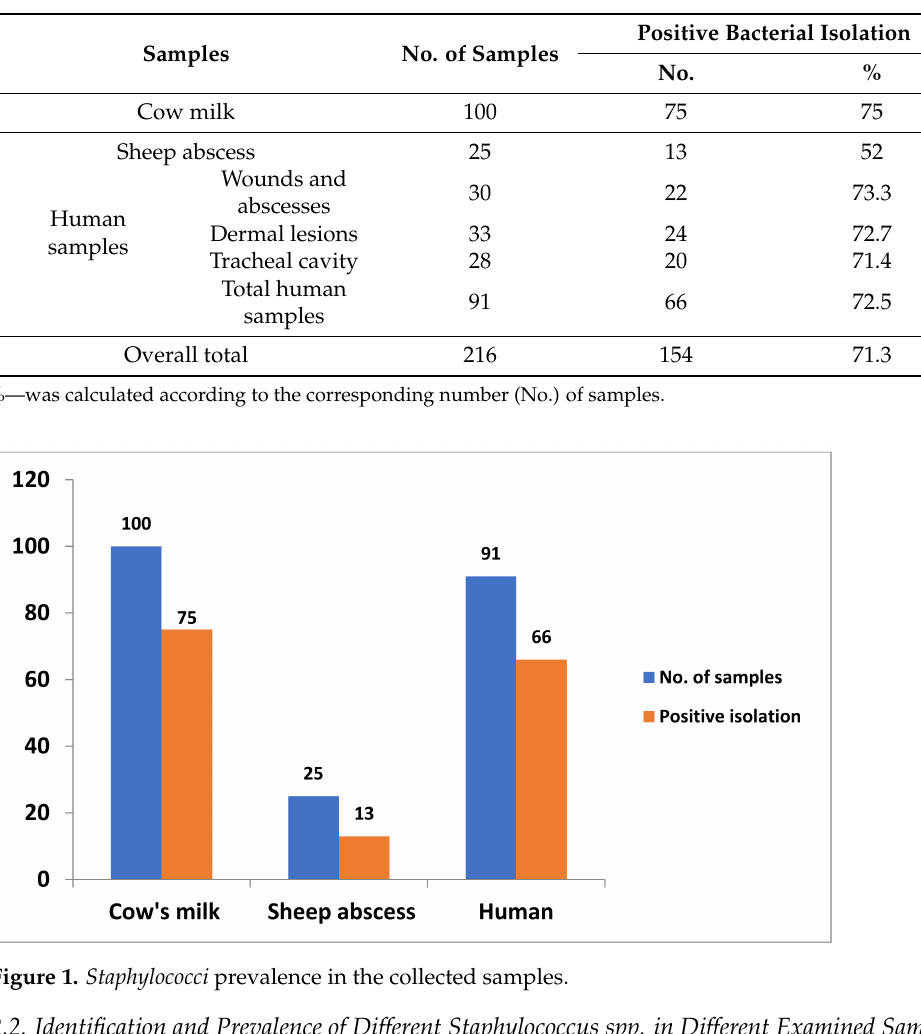
Table 1. Prevalence of Staphylococcus species in the different examined samples.